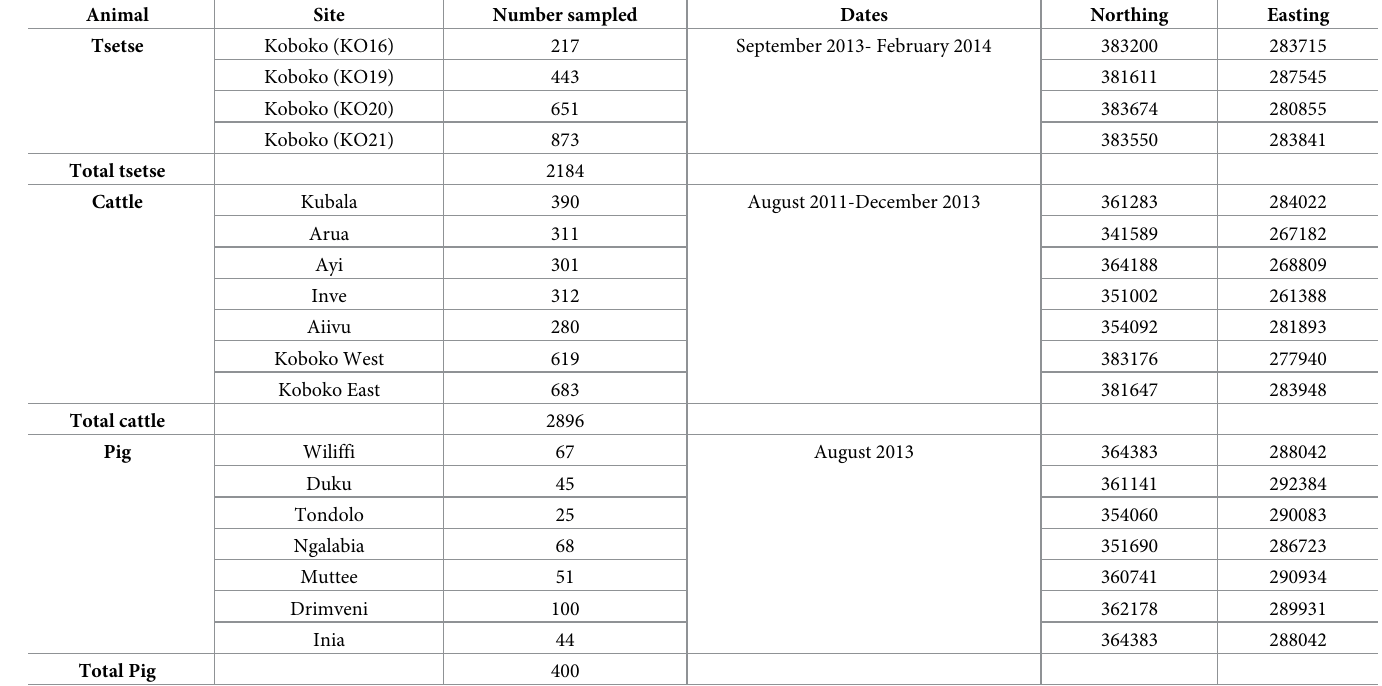
Table 1. Tsetse, cattle and pig sampling sites with corresponding numbers of animals sampled.